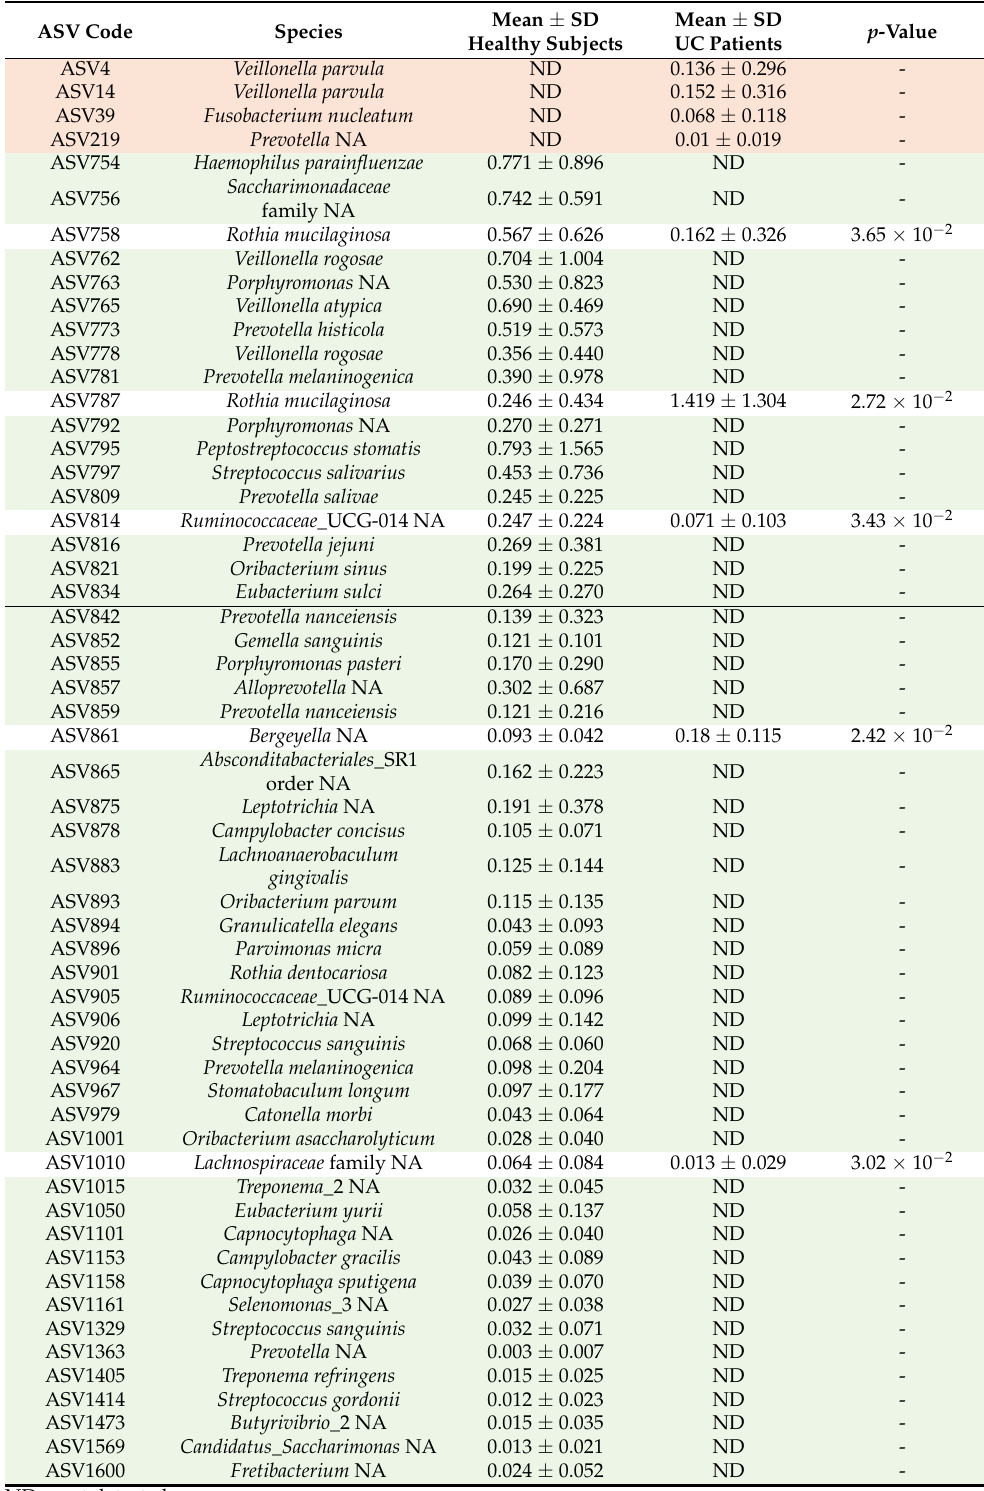
Table 2. Analysis of the differential relative abundance (%) at the ASV level: Only ASVs with statistically significant differences ( p -value < 0.05) based on the Mann–Whitney U test for non-related samples are shown. The ASVs that were detected only in the group of UC patients are marked in red, and the ASVs that were detected exclusively in the group of healthy donors are marked in